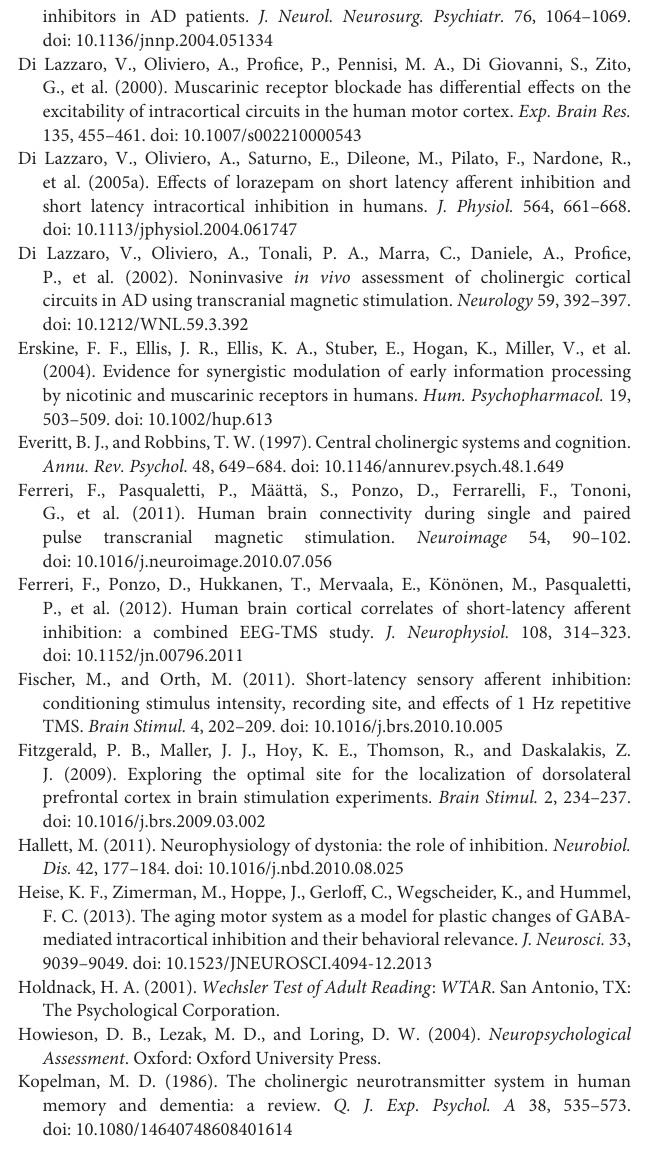
paradigm (t 22 = − 3.515, p = 0.002). Consequently, almost the same results were found in both ratio and subtraction methods in our analyses. Significant findings are shown with asterisks. Supplementary Figure 5 | Age-related correlations analyzed by a TEP amplitude subtraction method. There were significant age-related correlations with N45 TEP amplitude modulation at the left central ROI by M1-SAI ( r = − 0.572, p = 0.003, N = 24), with N100 TEP amplitude modulation at the left central ROI by M1-SAI ( r = 0.465, p = 0.022, N = 24), and with N100 TEP amplitude modulation at the left frontal ROI by DLPFC-SAI ( r = 0.595, p = 0.002, N = 24). Supplementary Figure 6 | Cognitive correlations analyzed by a TEP amplitude subtraction method. There were significant cognitive correlations between WTAR score and P60 TEP amplitude modulation by DLPFC-SAI ( r = − 0.612, p = 0.034, N = 12), between RBANS score and P60 TEP amplitude modulation by DLPFC-SAI ( r = − 0.744, p = 0.005, N = 12), and between ratio of TMT B/A and N100 TEP amplitude modulation by DLPFC-SAI ( r = 0.847, p = 0.001, N =